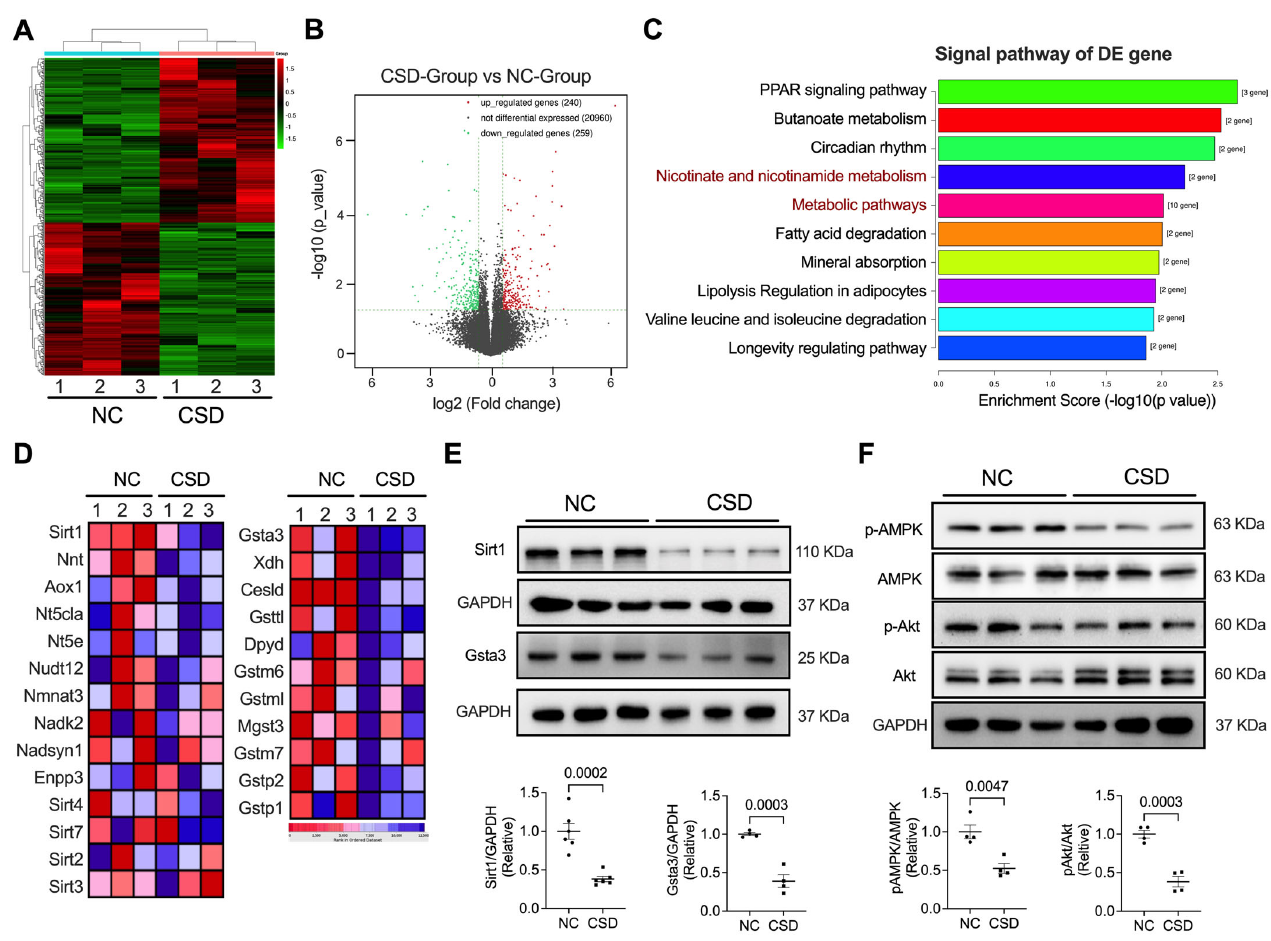
Figure 3. RNA sequencing revealed the Sirt1 − Gsta3 axis is involved in CSD − regulated heart dysfunc ‐ tion. ( A ) RNA sequencing heat map clustered in hierarchy volcano map ( B ) shows up − or down − reg ‐ ulated genes in NC and CSD hearts. ( C ) Signal pathway analysis of the differential expression (DE) gene of RNA − seq shows the top 10 pathways related to CSD treatment. ( D ) Heat map clustered in hierarchy shows that Sirt1 of the Nicotinate and nicotinamide metabolism pathway (Left panel) and Gsta3 of the metabolic pathway were downregulated in the CSD heart. ( E ) Representative Western blot images and quantification of Sirt1 and Gsta3 in NC and CSD hearts. ( F ) Representative Western blot images and quantification of phosphorylation or total of AMPK and Akt in NC and CSD hearts.